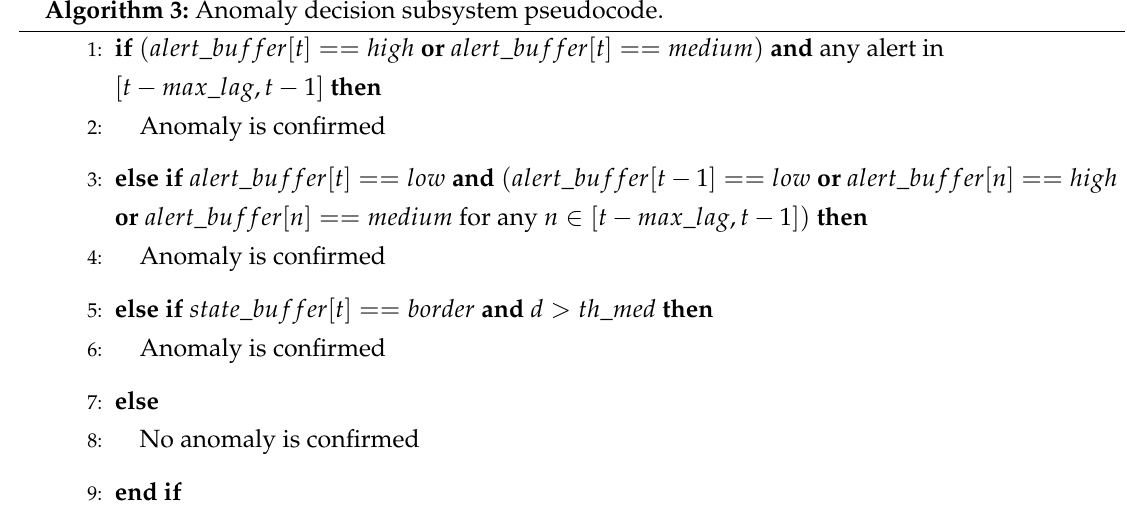
Algorithm 3: Anomaly decision subsystem